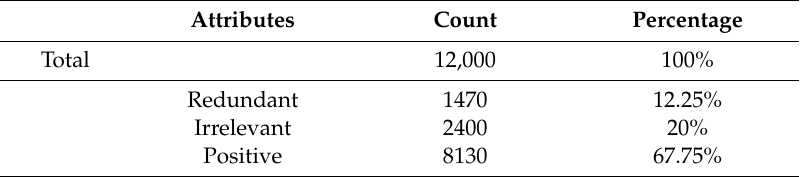
Table 5. Volume and ratio of our extracted requirements’ polarity.